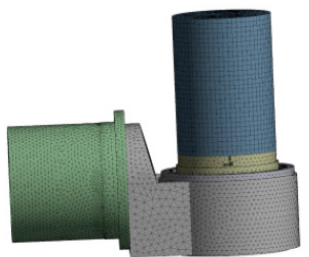
Figure 4. Finite element model of direct-drive turntable.